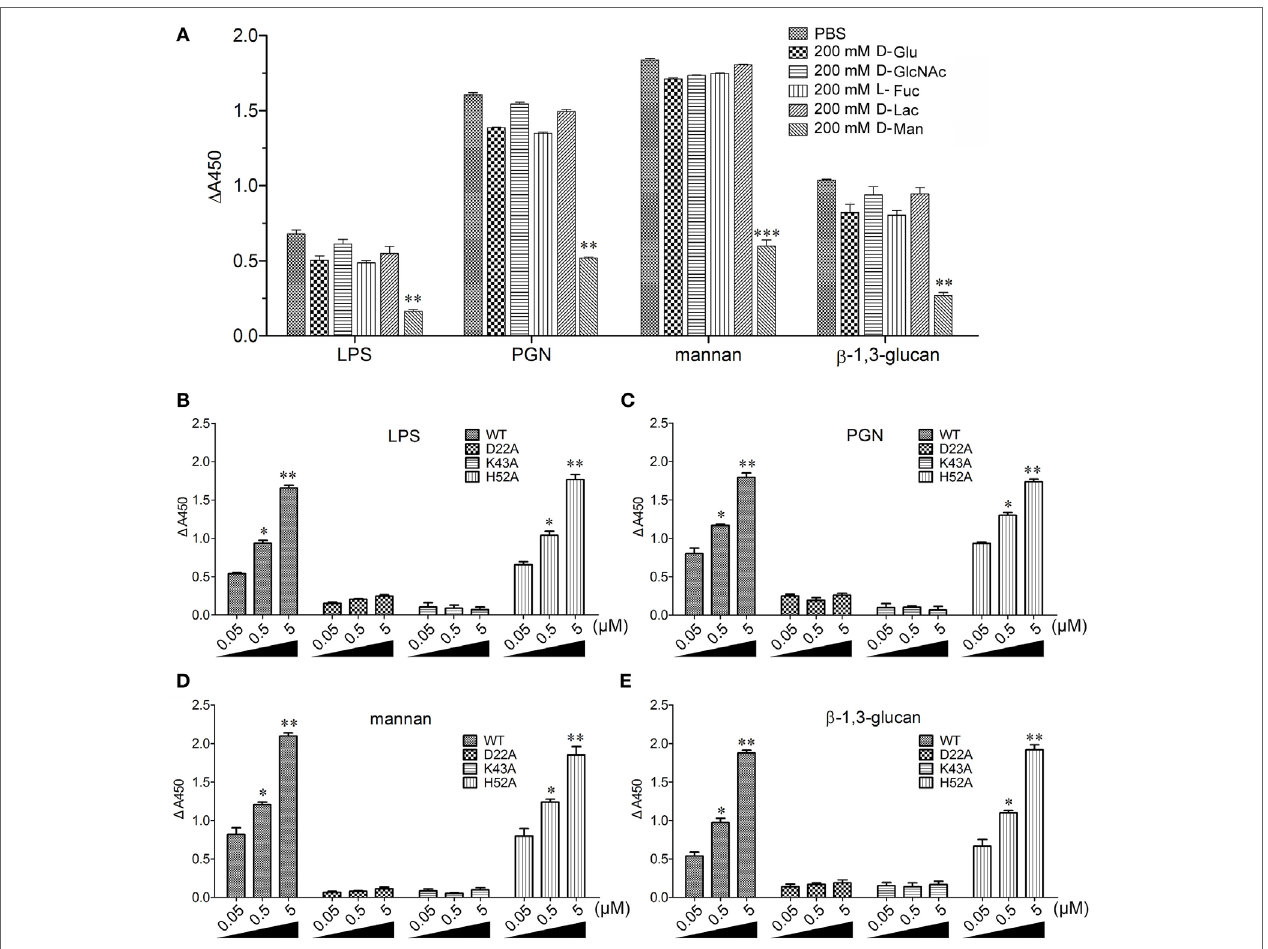
FigUre 4 | Recombinant Crassostrea gigas DM9 domain containing protein 1 (rCgDM9CP-1) binding to pathogen-associated molecular patterns (PAMPs) in d -mannose-dependent manner. (a) rCgDM9CP-1 was pre-incubated with 200 mM d -glucose ( d -Glu), d -GlcNAc, l -fucose ( l -Fuc), d -lactose ( d -Lac), and d -mannose ( d -Man), respectively, and the binding to PAMPs was determined by enzyme-linked immunosorbent assay (ELISA) ( n = 6). Data are representative of three independent experiments. * P < 0.05, ** P < 0.01, and *** P < 0.001. The quantitative binding of wild-type rCgDM9CP-1 and mutants to immobilized lipopolysaccharide (LPS) (B) , peptidylglycan (PGN) (c) , mannan (D) , and β -1,3-glucan (e) was determined by ELISA ( n = 6). Data are representative of three independent experiments. Error bars indicated standard deviations of the mean. * P < 0.05, ** P <